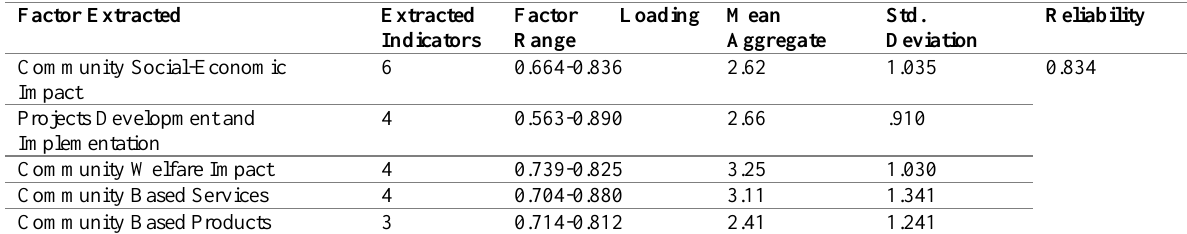
Table 4: Community Development Extracted Factors